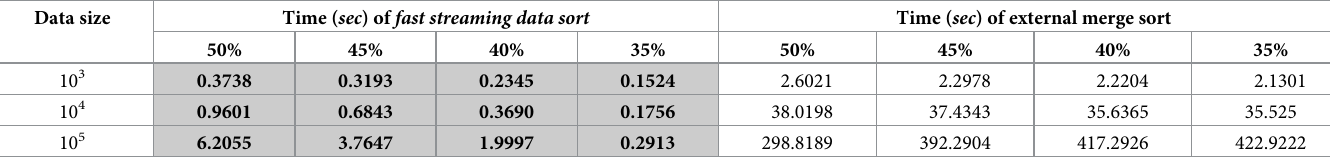
Table 5. Comparison of sorting times of fast streaming data sort and external merge sort. Data